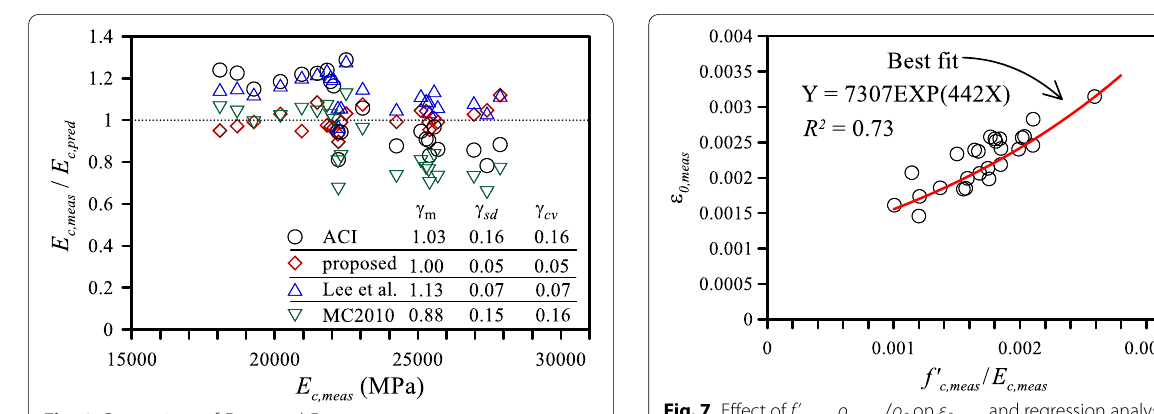
Fig. 6 Comparison of E c,meas and E c,pred . Fig. 7 Effect of f’ c,meas ρ c,meas / ρ 0 on ε 0,meas and regression